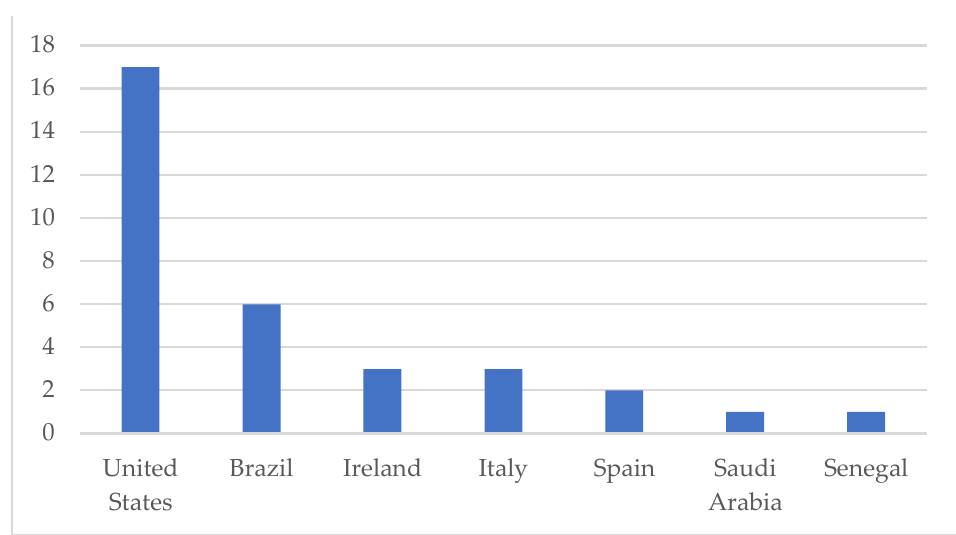
Figure 2. Countries where the articles were produced. Another significant result regards the publications’ academic fields. We classified such data according to the Web of Science and ScimagoJR records. Two fields condense most of the journals in which the analyzed papers were published. The health care sciences and services field presents eight articles (24.3%, while the nursing field presents five (15.2%) analyzed articles. The complete data can be seen in Figure 3. Regarding the journals, the articles were published in 26 different journals, all described in Appendix A.